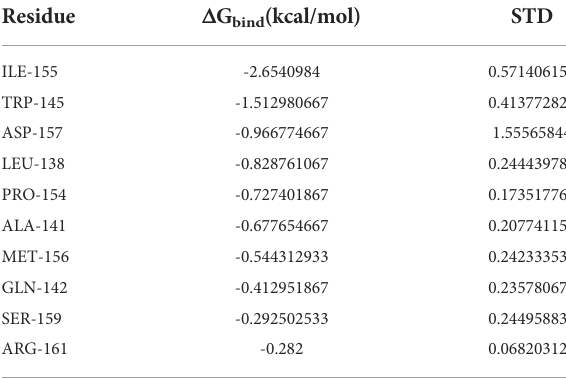
TABLE 4 The binding energy of top10 amino acids contributes to minocycline/caspase-1 binding.